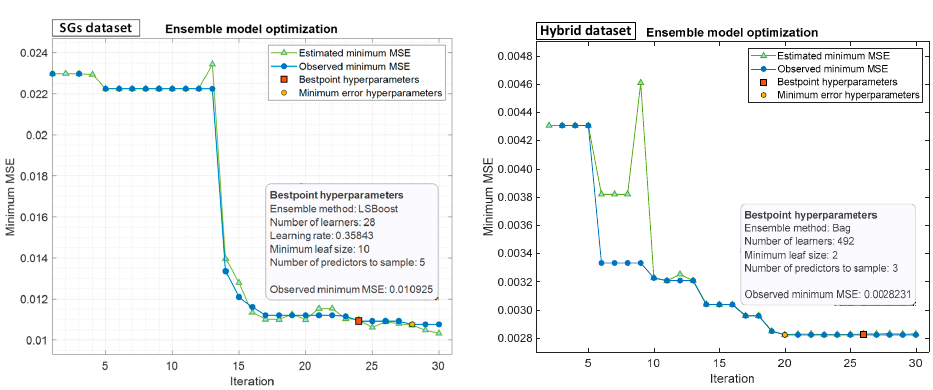
Figure 15. Minimum MSE plots for ensemble model method in both experimental and hybrid datasets, which were updated by Bayesian optimization runs.